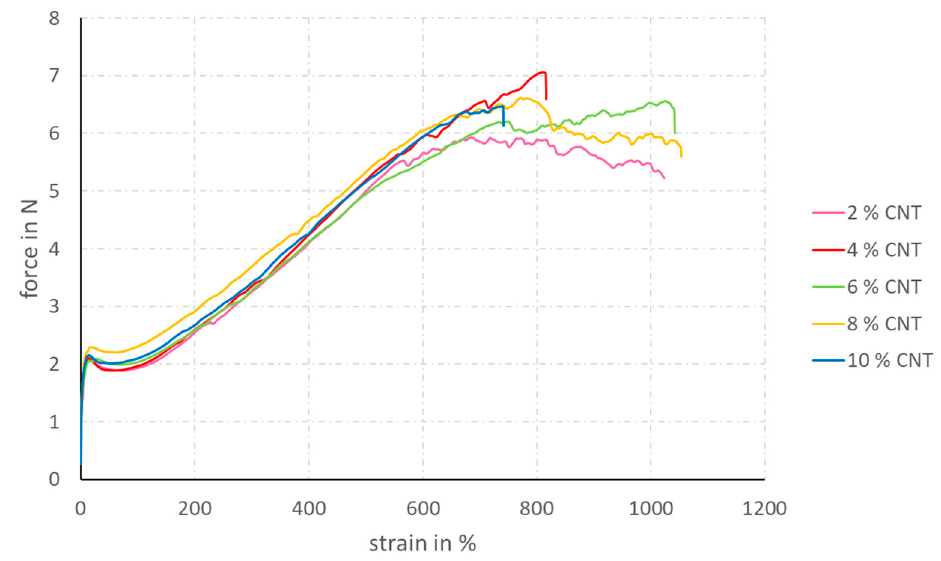
Figure 5. Strain–force diagram of TPU multifilament yarns coated with coating solutions containing a constant SC of 6 wt% and different CNT contents in the SC.